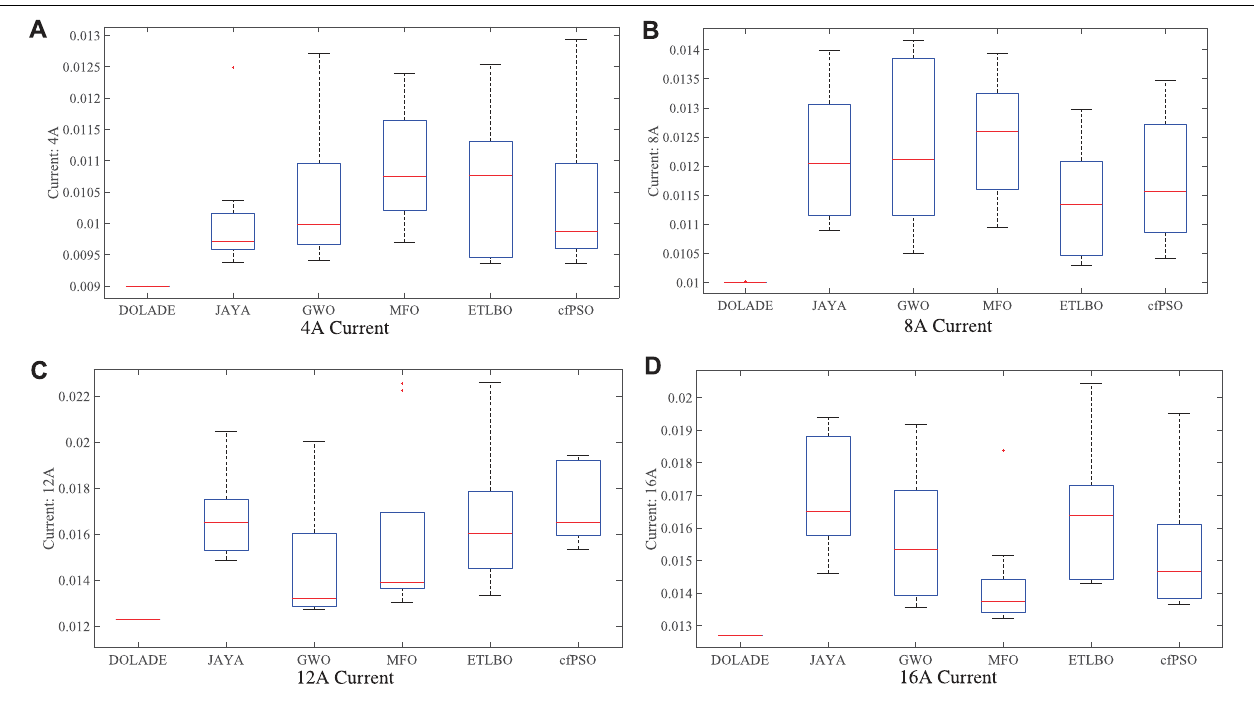
FIGURE 8 | Best RMSE boxplot in 30 runs of six algorithms under different currents.